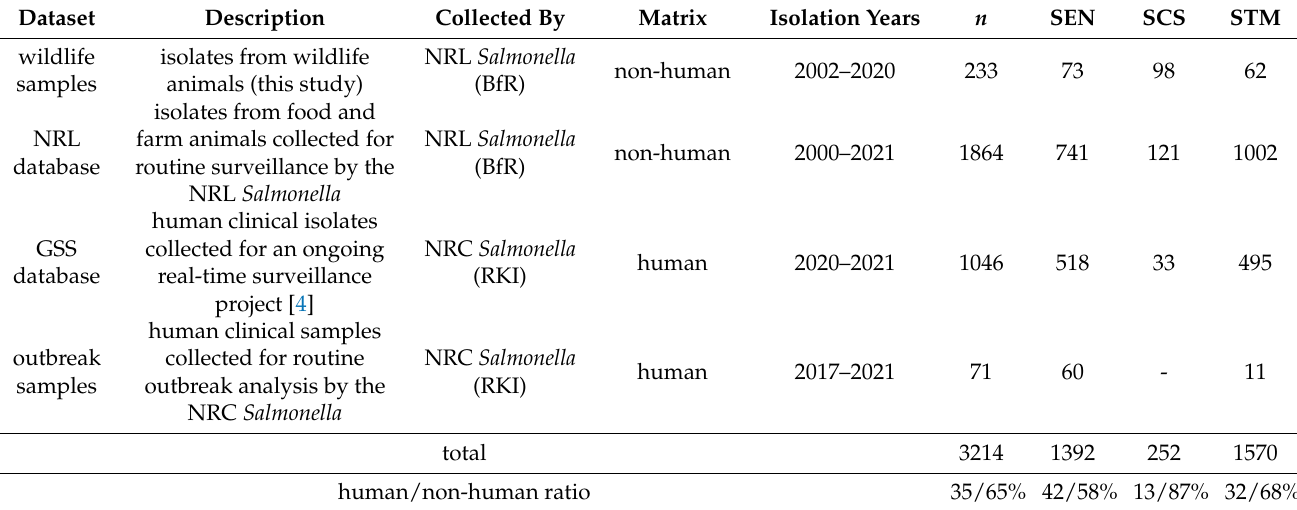
Table 2. Isolates for joint